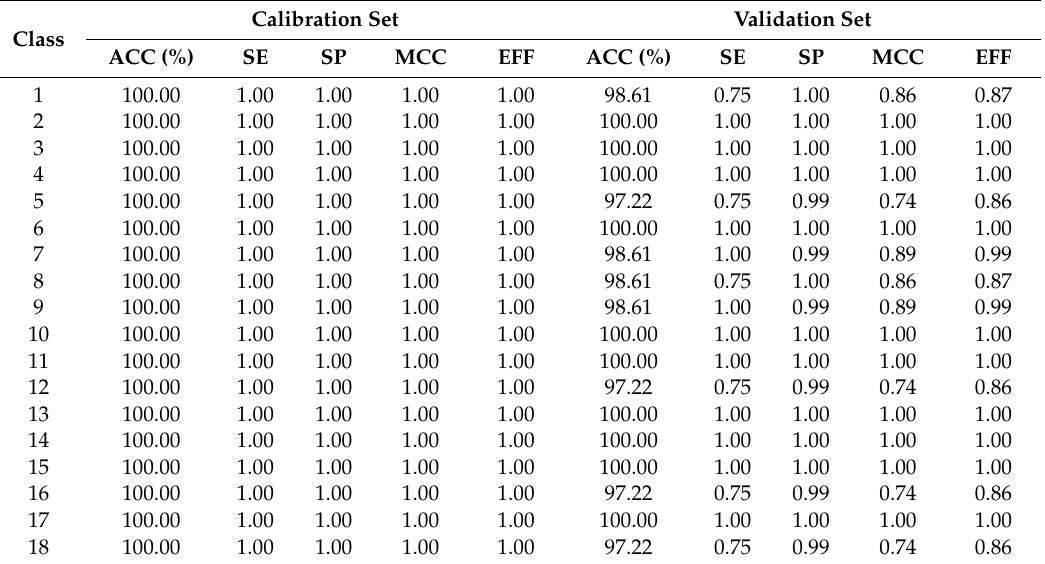
Table 3. The major parameters of SVM model based on NIR full spectra data.